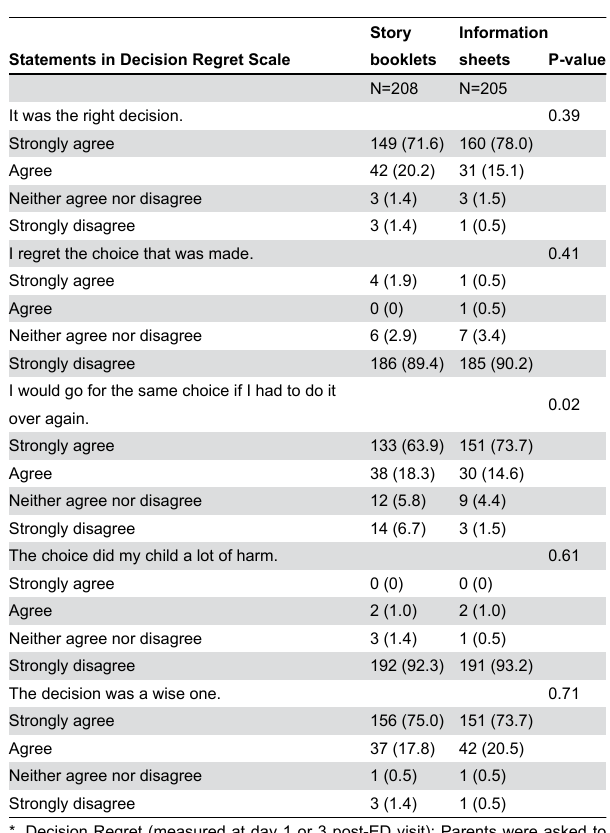
Table 6. Comparison of decision regret scale *